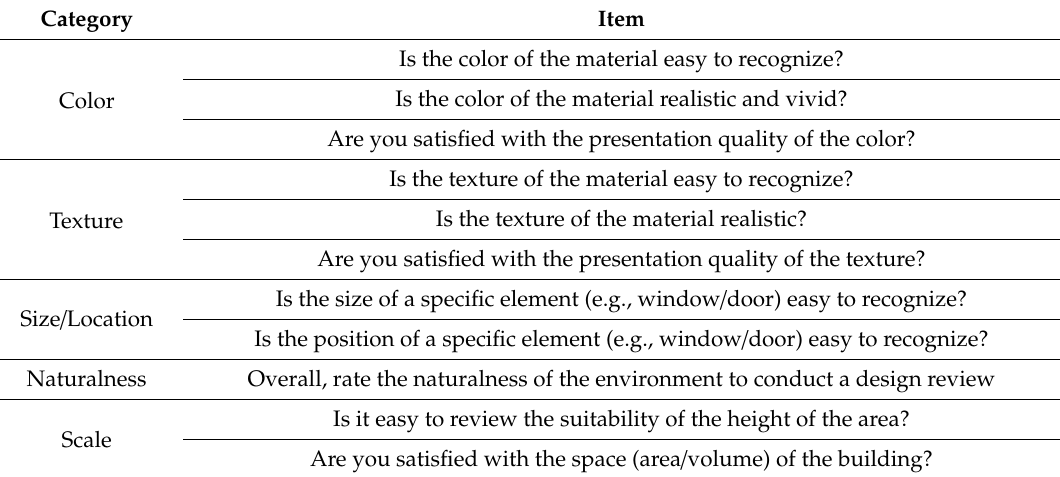
Table 1. Questionnaire category and item for quality of visual presentation.